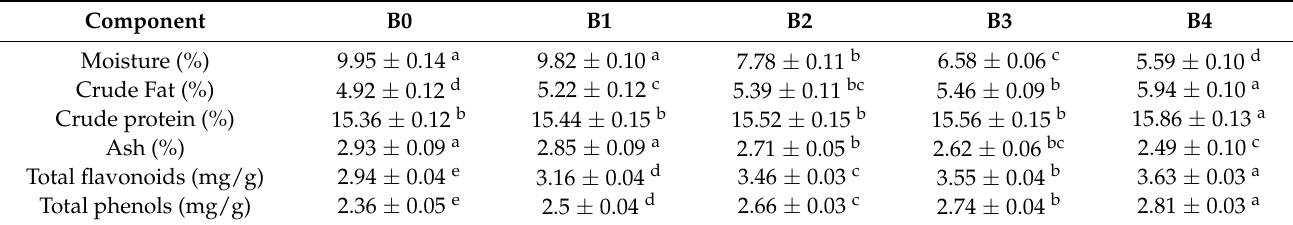
Table 2. Main chemical components of the wheat